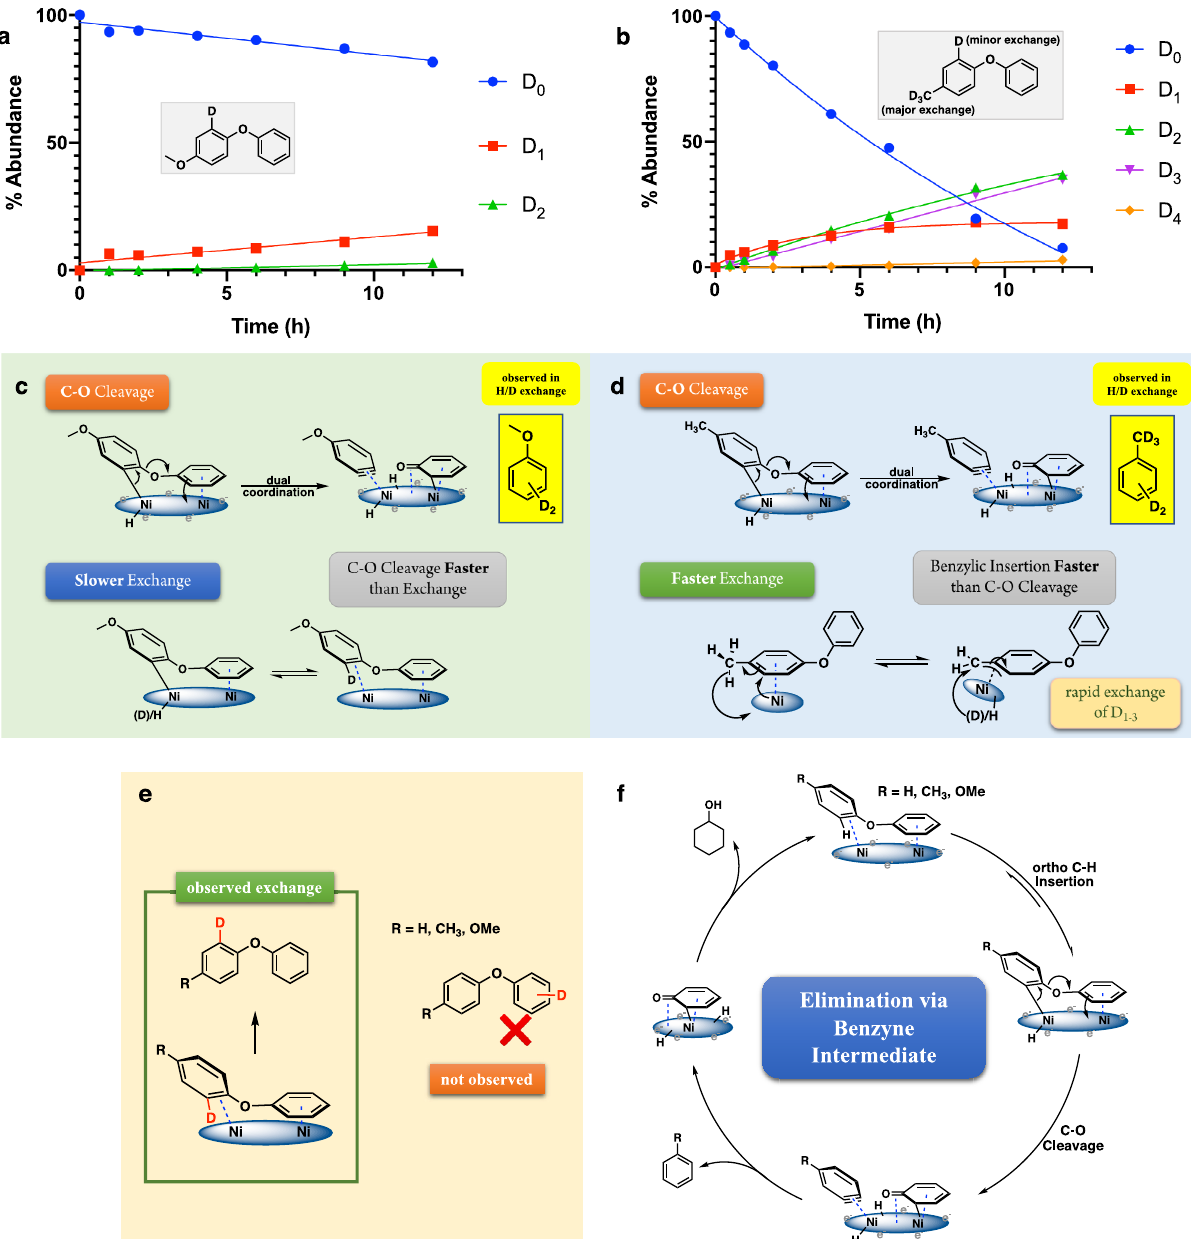
Fig. 5 Effects of methyl and methoxy substituents on diaryl ether cleavage mechanism. a H/D exchange time courses and exchange locations for methoxylated diphenyl ether. b H/D exchange time courses and exchange locations for methylated diphenyl ether. D n ( n = 0 − 4) represent numbers of deuterium atoms incorporated. For additional analyses (NMR and MS Spectra) see supplementary Figs. 4 – 19. c Proposed cleavage and exchange mechanisms for methoxylated diphenyl ethers. d Proposed cleavage and exchange mechanisms for methylated diphenyl ethers. e Exchange at the ortho C-H of the substituted ring, consistent with the dual-ring coordination. f Proposed cleavage mechanism of DPE, methylated DPE and methoxylated